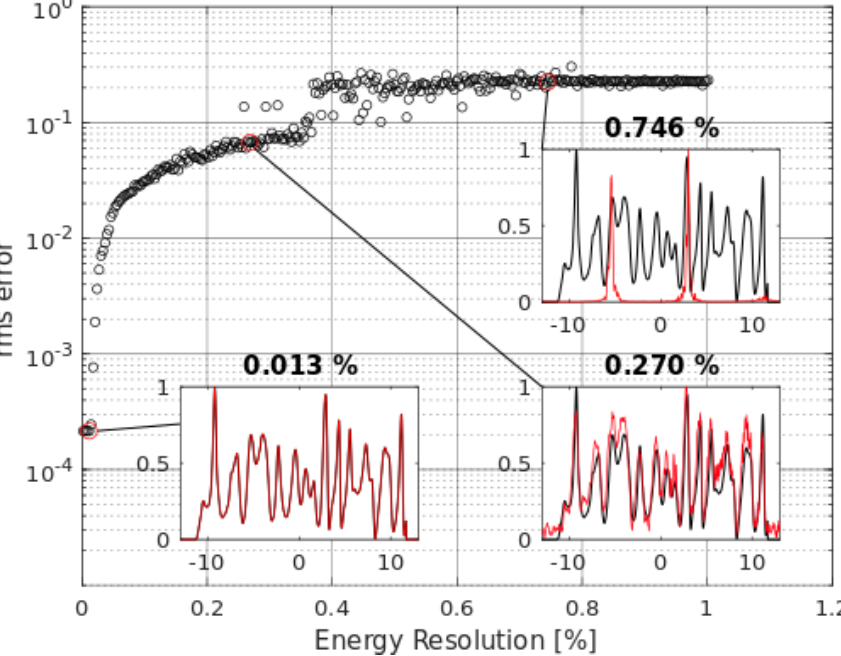
Figure 5. Ptychographic reconstruction of a simulated SASE waveform as a function of relative energy resolution. The insets show the original (black curve) and the reconstructed (red curve) X-ray waveforms as functions of time for ∆ E / E = 0.013%, 0.270% and 0.746%.